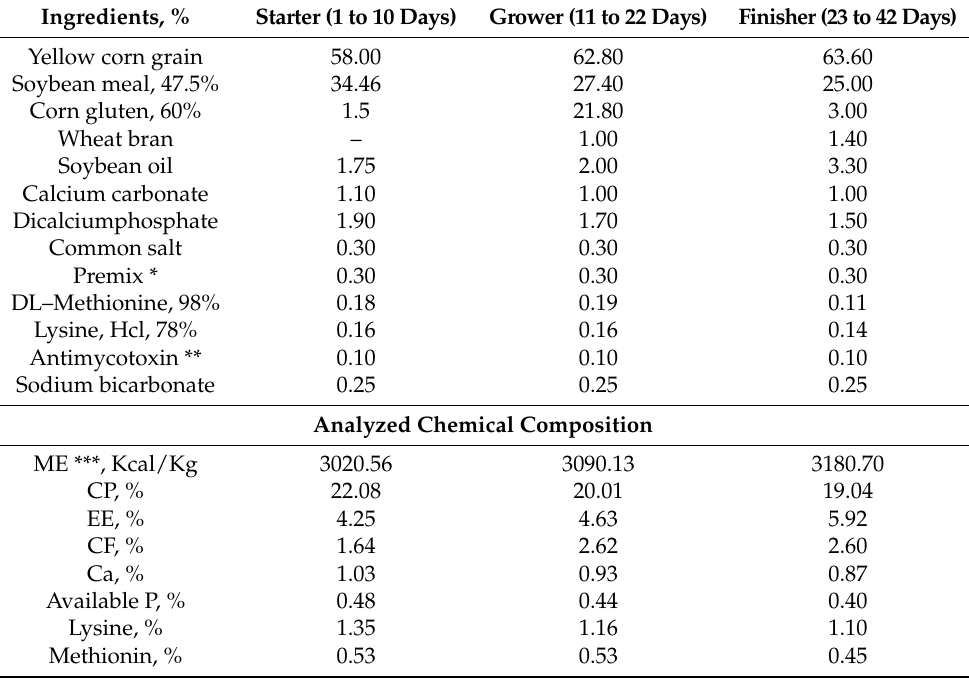
Table 1. Ingredients and chemical composition of the basal diet (as